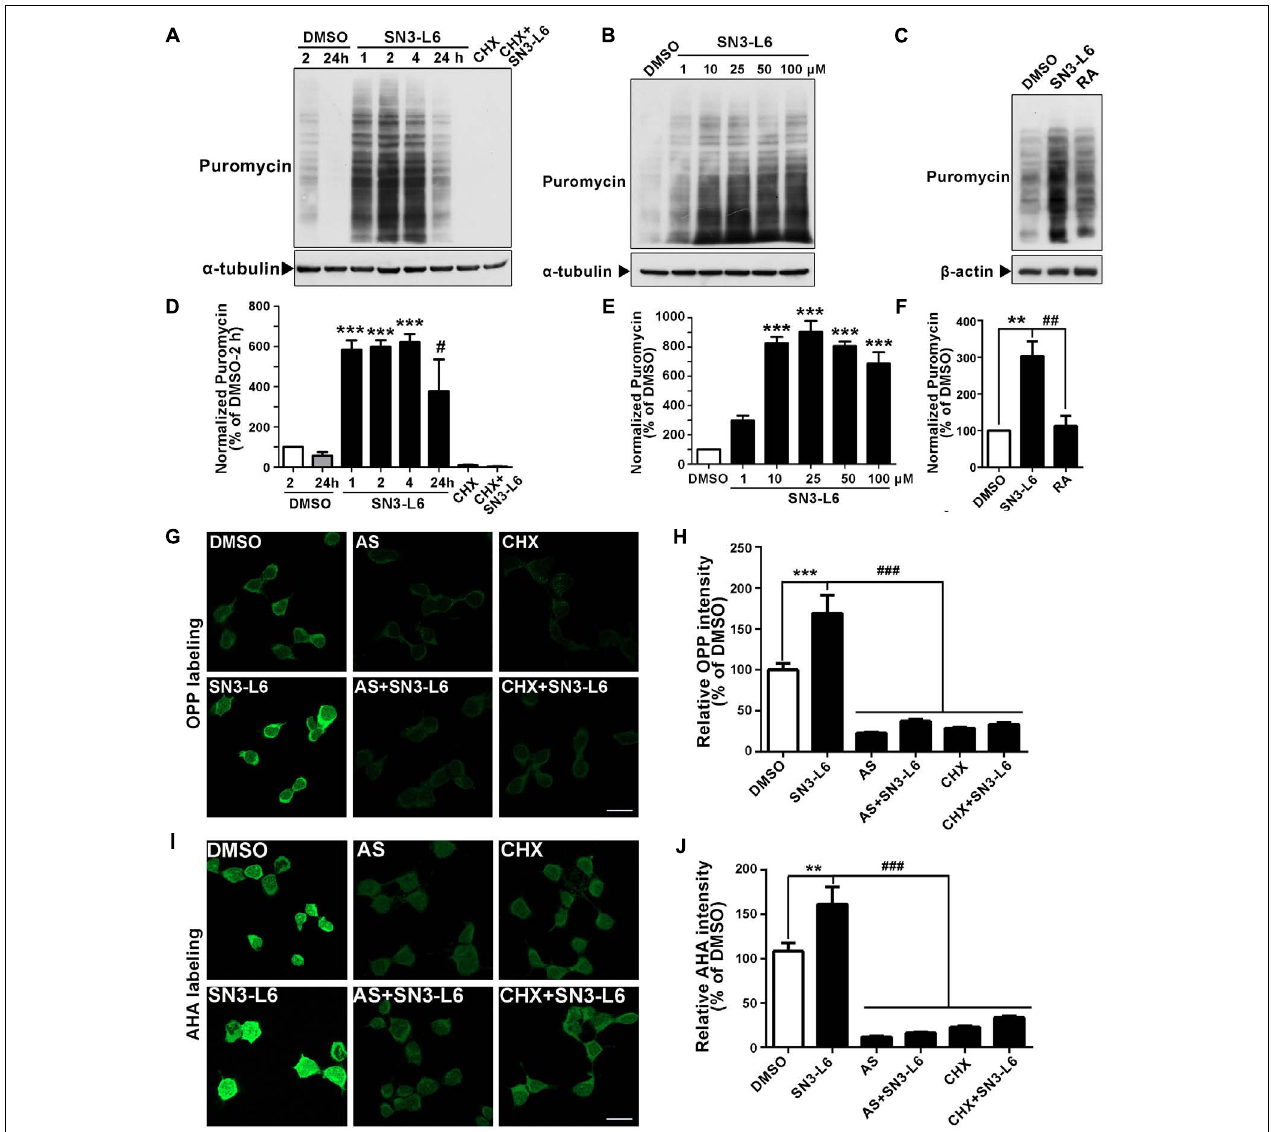
FIGURE 3 | SN3-L6 promotes mRNA translation. Representative Western blots showing the effects on puromycin incorporation by SN3-L6 (25 µ M) at different treatment time (A) and different concentrations (1–100 µ M; B ). α -tubulin was used as a loading control. Cycloheximide (CHX) (12 µ M) was used to block translation. (C) Comparison of the effects on puromycin incorporation by SN3-L6 (25 µ M) and RA (10 µ M). β -actin was used as a loading control. (D) Quantification of puromycin incorporation levels of (A) . ∗∗∗ P < 0.001, SN3-L6-2 h vs. DMSO-2 h; # P < 0.05, SN3-L6-24 h vs. DMSO-24 h. (E) Quantification of puromycin incorporation levels of (B) . ∗∗∗ P < 0.001, SN3-L6 vs. DMSO. (F) Quantification of puromycin incorporation levels of (C) . ∗∗ P < 0.01, SN3-L6 vs. DMSO; ## P < 0.01, RA vs. SN3-L6. (G) Representative images of O-propargyl-puromycin (OPP) labeling of newly synthesized polypeptides treated by SN3-L6 (25 µ M). (H) Quantification of OPP signal intensity. (I) Representative images of L-azidohomoalanine (AHA) labeling of newly synthesized proteins. (J) Quantification of AHA signal intensity. For (H,J) , ∗∗ P < 0.01, ∗∗∗ P < 0.001, SN3-L6 vs. DMSO; ### P < 0.001, anisomycin (AS) or CHX single or co-treatment with SN3-L6 vs. SN3-L6. All data shown in this figure are presented as mean ± SEM from at least three independent experiments. Statistical analysis was subjected to one-way ANOVA with Bonferroni multiple comparison test. Scale bars, 20 µ